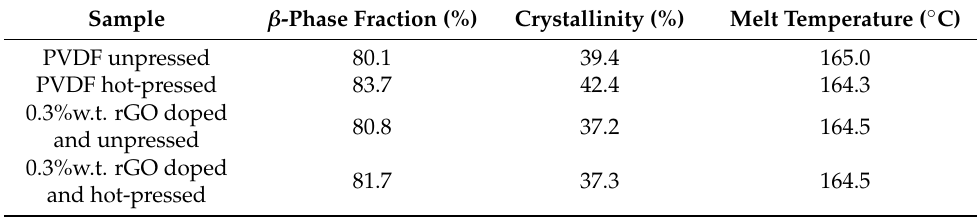
Table 1. Compiled chemical characteristics of the four solution-cast PVDF